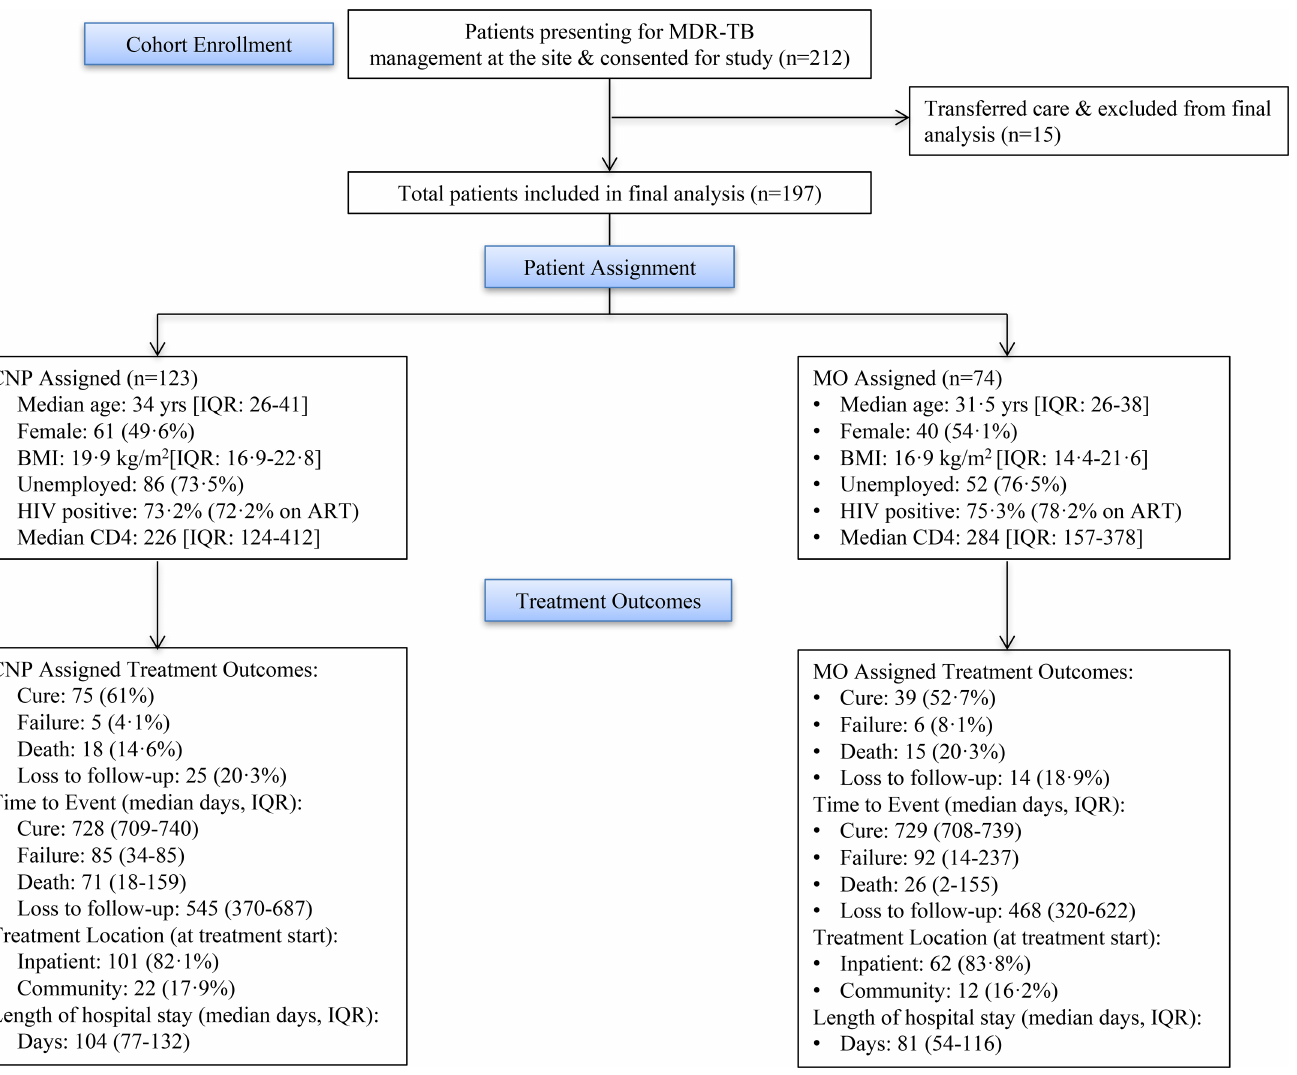
Fig 1. Participant enrollment and MDR-TB treatment outcomes between CNP and MO.